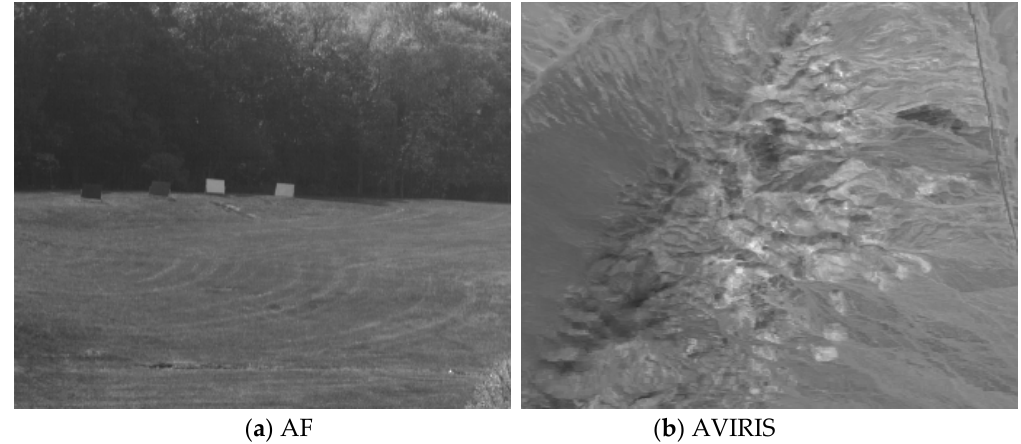
Figure 2. ( a ) is a sample band from AF data and ( b ) is a sample band from AVIRIS